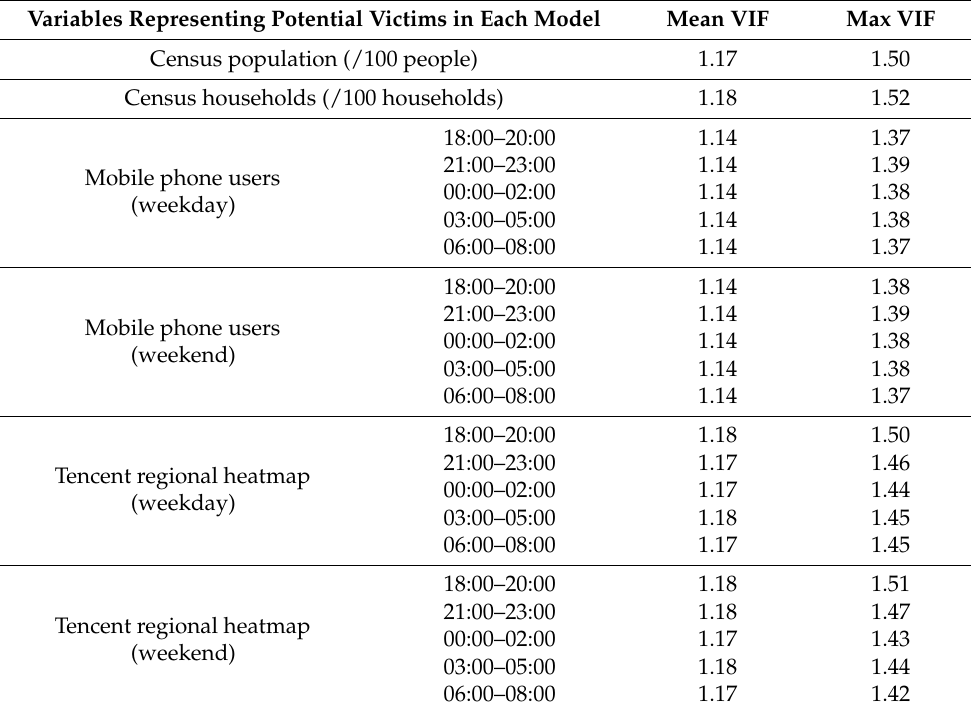
Table 3. The VIF values of the independent variables in each model (22 models in total). Variables Representing Potential Victims in Each Model Mean